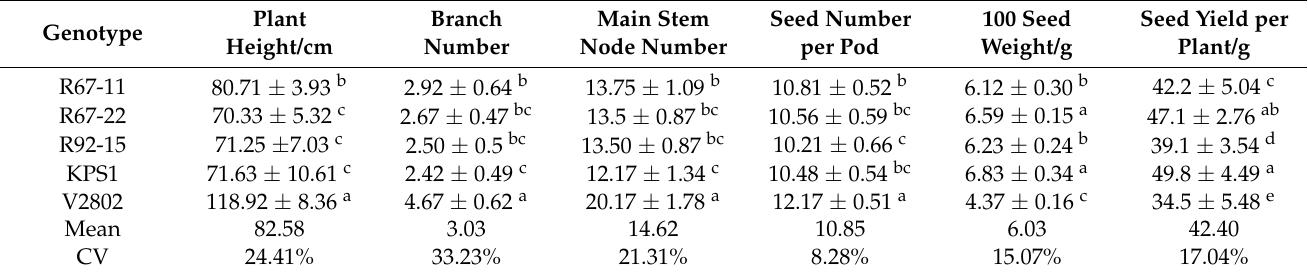
Means ± S.D. ( n = 12) in the same column with different letters were significantly different based on Duncan’s multiple range test comparisons ( p < 0.05). CV = coefficient of variation.